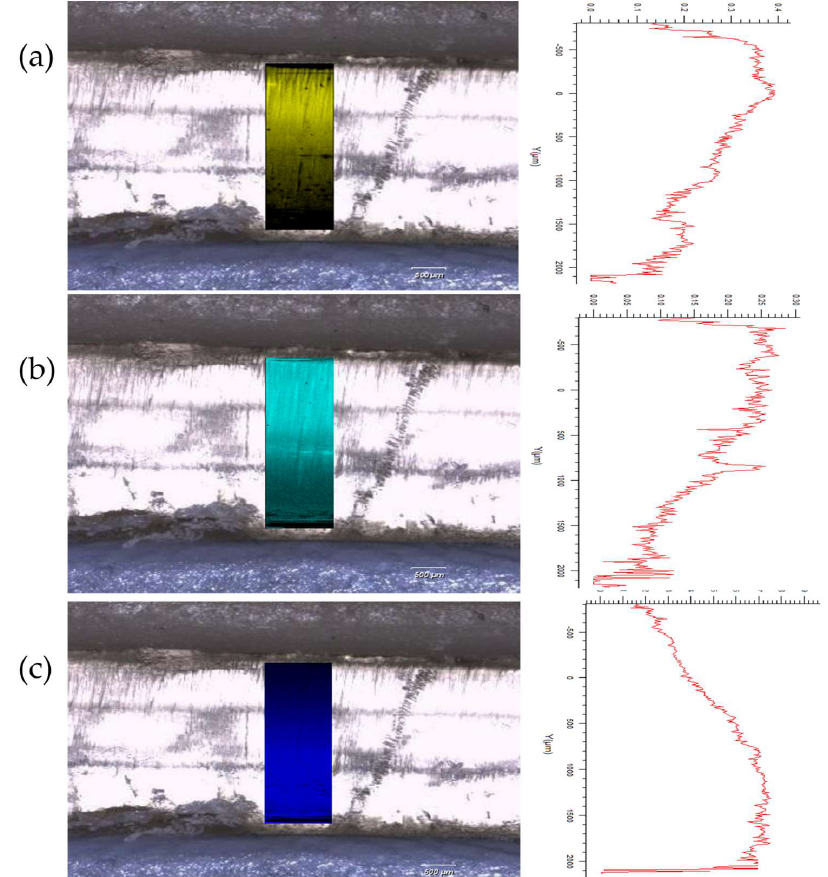
Figure 4. Raman mapping of a Type I polypill across the naproxen, aspirin, and paracetamol layers